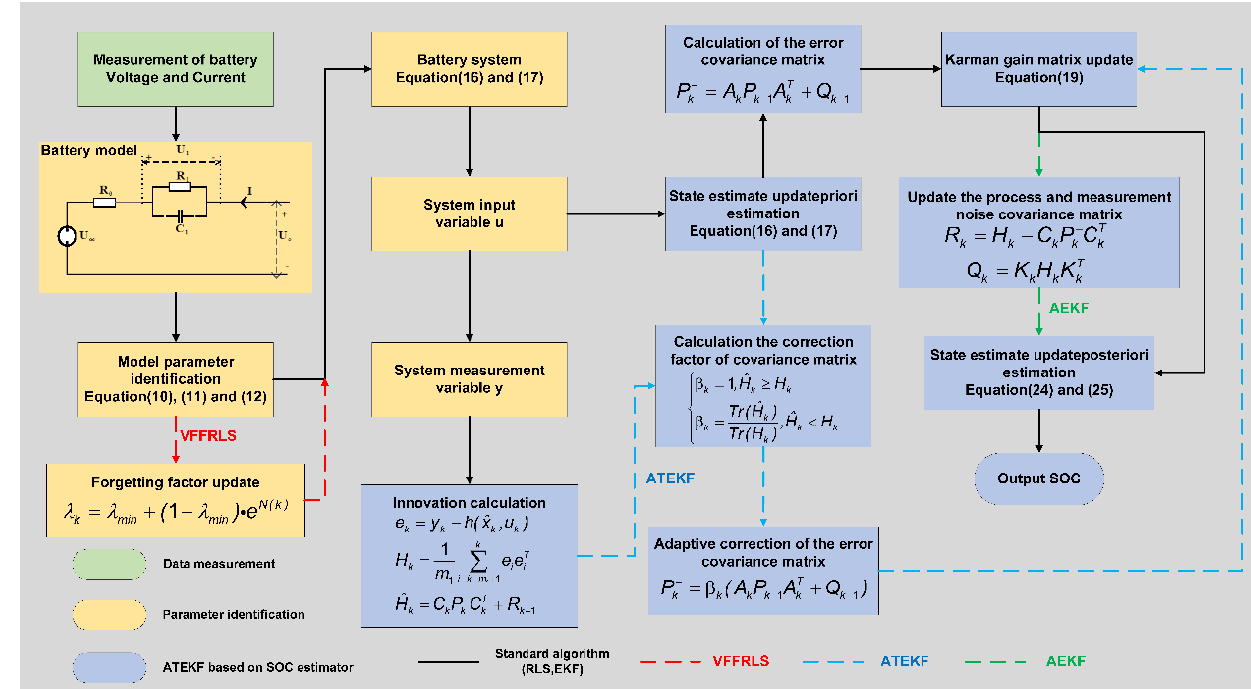
Figure 2. Overall process of SOC estimation based on ATEKF. Algorithm 2. ATEKF algorithm.